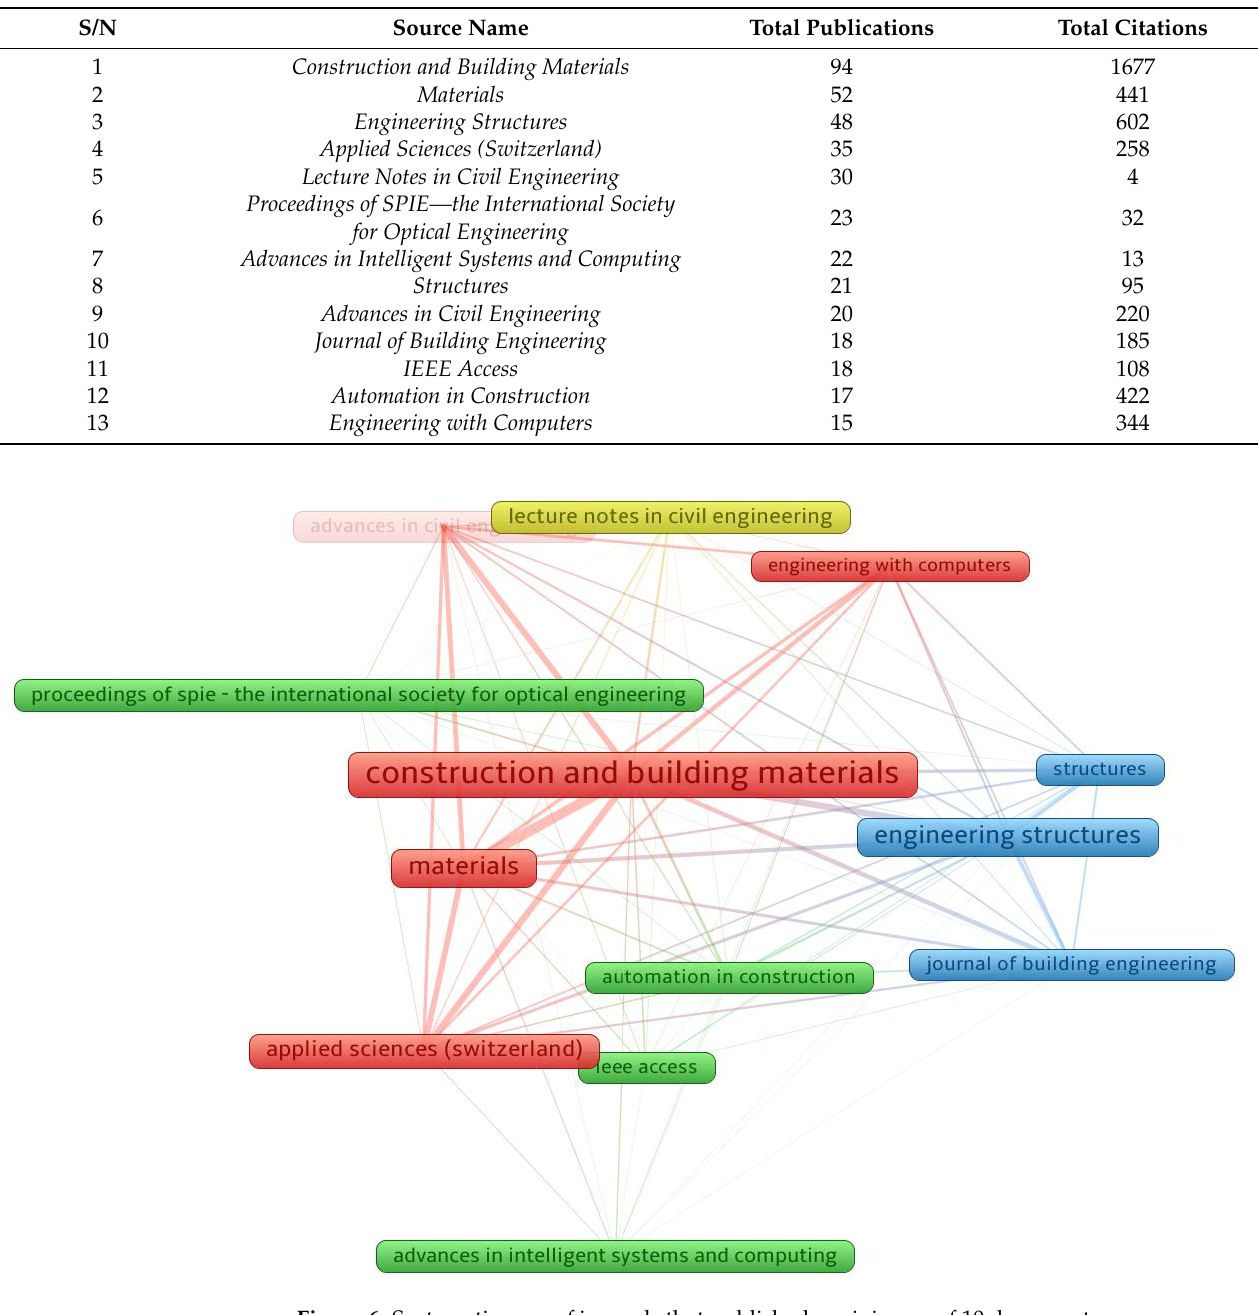
Table 1. List of journals publishing a minimum of 15 documents in the subject domain from 2001 to